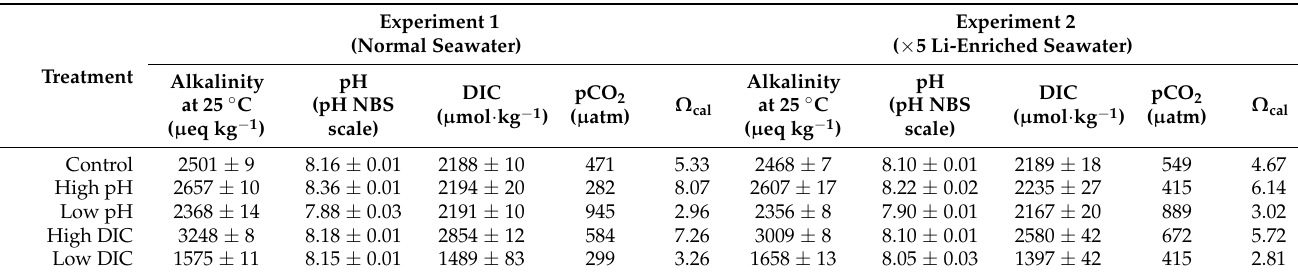
Table 1. Water chemical variables for all treatments in both experiments. Alkalinity and pH were measured every week and DIC was measured every second week; pCO 2 and Ω cal were calculated using the CO2SYS software. Uncertainties represent the external error (2 σ